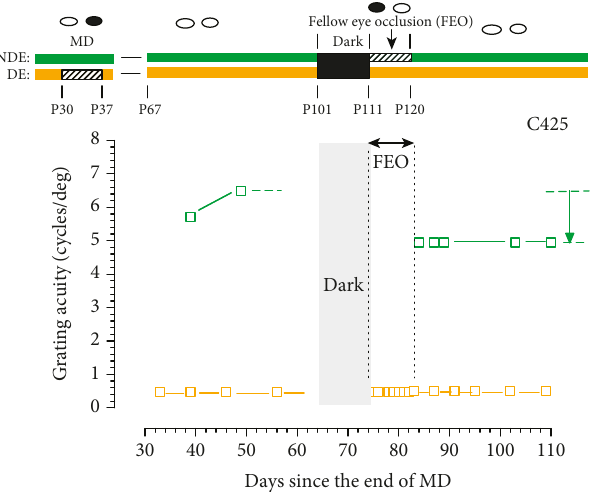
Figure 3: The grating acuity of the deprived eye (orange symbols) and the binocular acuity (green symbols) of a monocularly deprived kitten (C425) surrounding a 10-day period of total darkness followed by a 9-day period of fellow eye occlusion (FEO). As with the previous fi gures, the visual histories of the two animals are depicted in schematic form by the bars and icons above the two